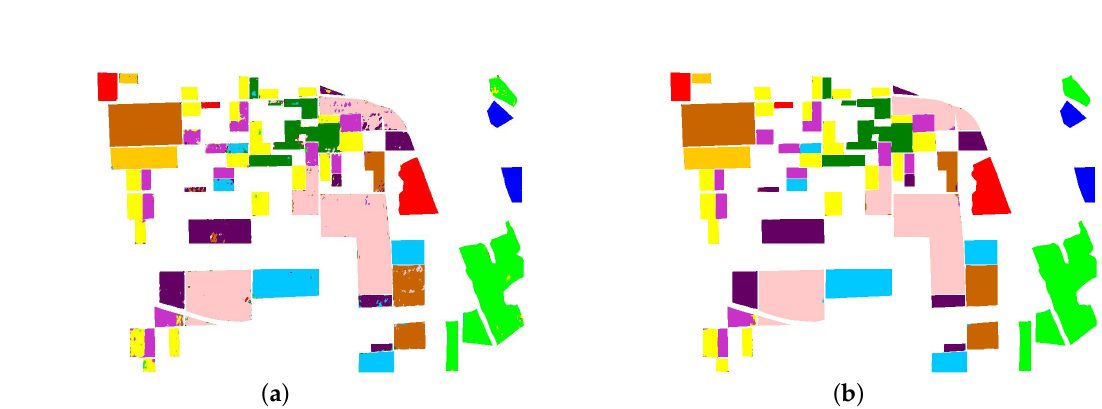
Figure 9. Classification result of AIRSAR Flevoland. ( a ) Lenet-5. ( b )